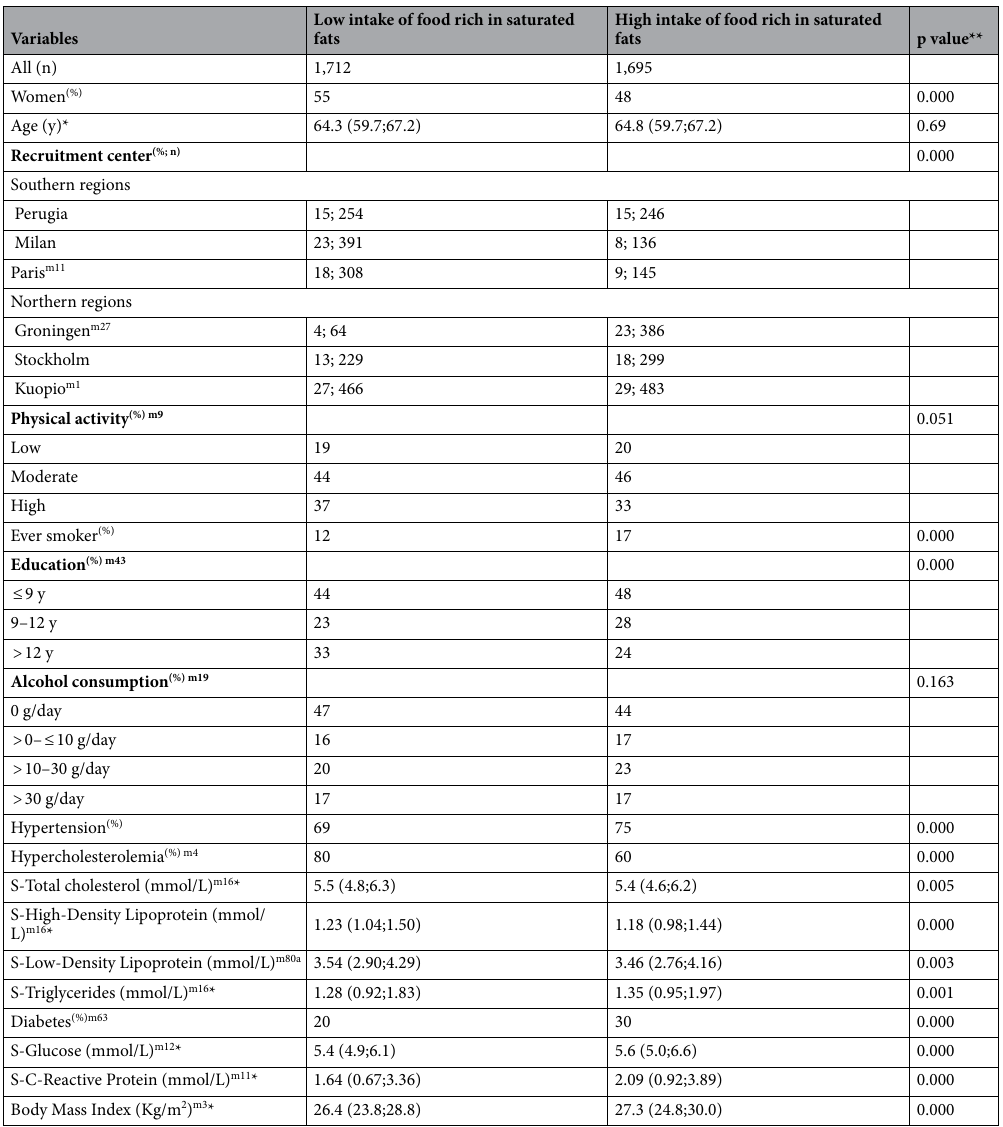
Table 1. Baseline characteristics of the participants included in the IMPROVE study by intake of food rich in saturated fats. *median and IQ range. **p values were calculated with Pearson’s chi-squared test for discrete variables and Wilcoxon rank-sum test for continuous variables. S: serum. m: